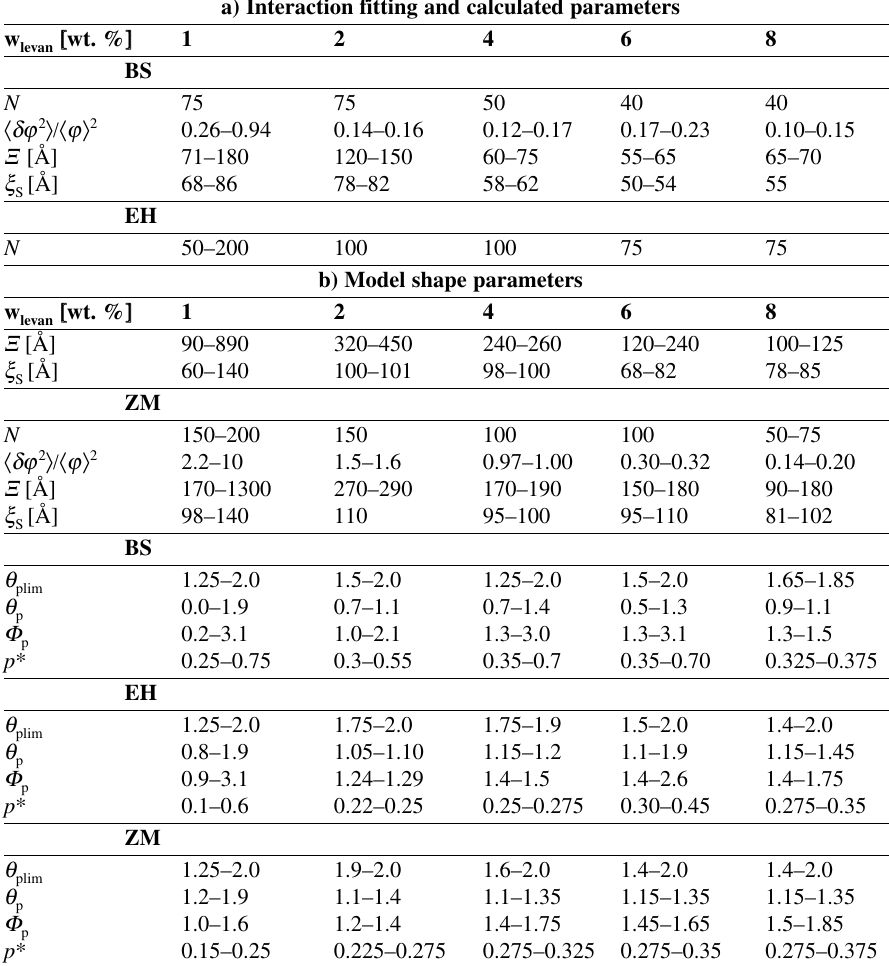
Table 1. a) Interaction parameters of the fits to the experimental SAXS data, and b) shape parameters for BS, ZM, and EH levans. The ranges of parameter values of good fits are